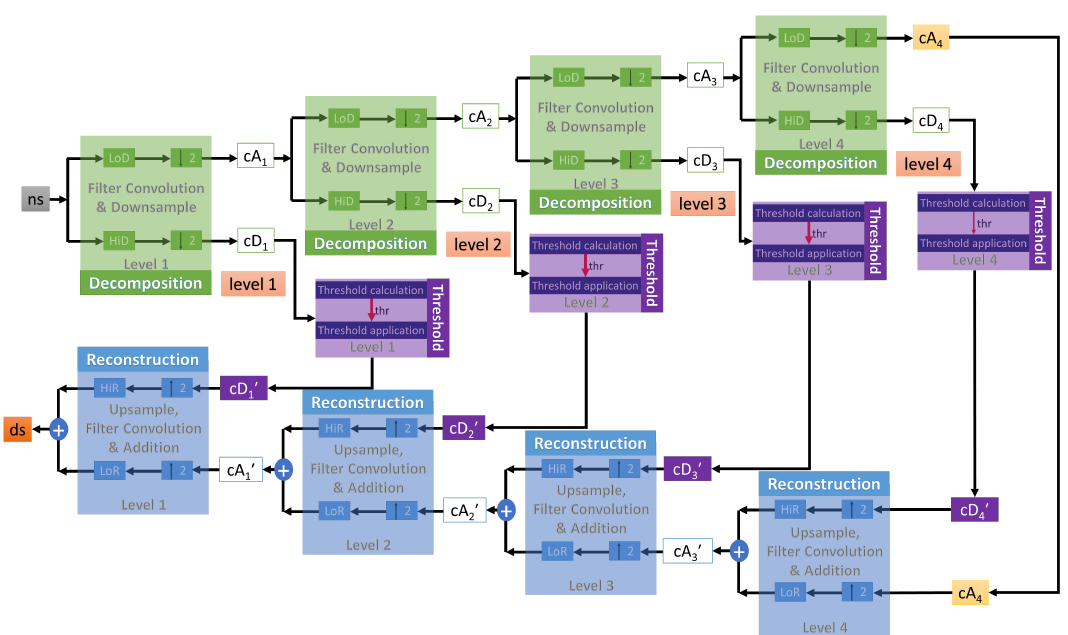
Figure 5. Detail operations in each denoising step with a total of four